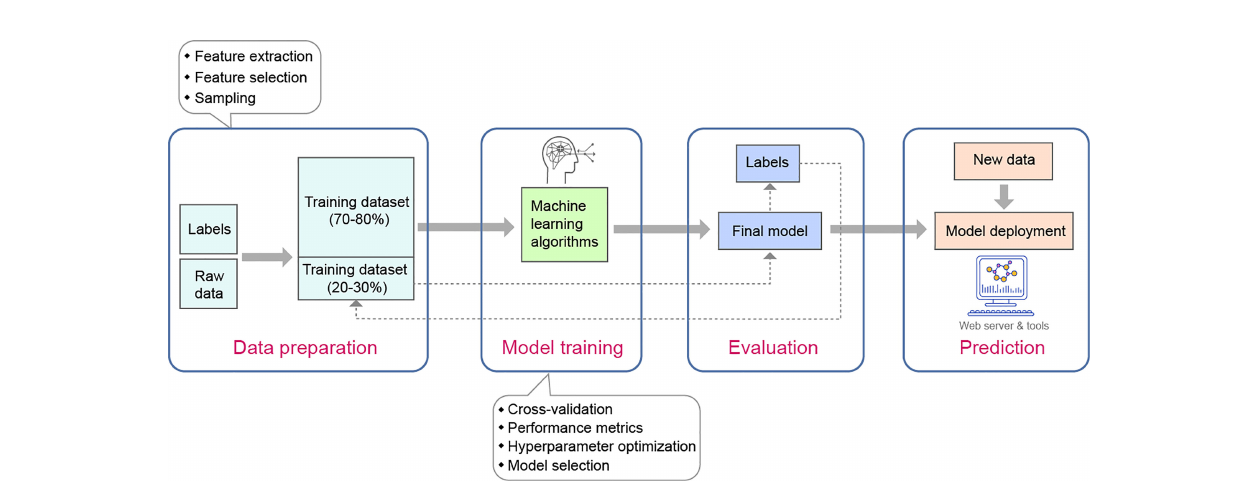
FIGURE 1 | Example schematic work fl ow of constructing a machine learning predictor (supervised learning approach). The overall fl ue contains four steps, namely, data preparation, model training, evaluation, and prediction. Step1: data are preprocessed to ensure suitability for machine learning and are split into training and test cohorts. The preprocessed data are characterized (i.e., numerical vector with labels) by feature extraction method and the optimal features are charactered by feature selection methods (such as by MRMD software). Step2: A type of machine learning algorithm (e.g., SVM, RF, or neural network) is chosen based on the data to be used and the desired task, and the models are trained on training dataset. Step3: model performance is evaluated using the test dataset through cross-validation and by means of metrics such as ROC or accuracy. During this step, hyperparameter optimization (or hyperparameter tuning) is usually performed to determine the right combination of hyperparameters that maximizes the model performance: for example, the maximum depth allowed for a decision tree algorithm and the number of trees contained in a random forest algorithm. Step4: an optimal model is chosen as the fi nal model and packaged appropriately for users (e.g., online webserver for prediction or scripts for local